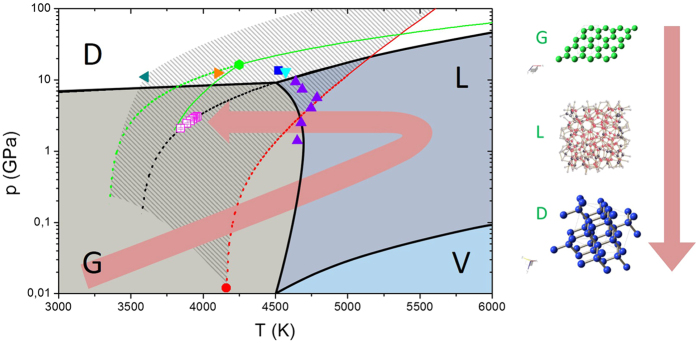
The phase diagram of carbon.The four regions of diamond D (white), graphite G (light grey), gaseous carbon V (light blue) and liquid carbon L (blue) are separated by coexistence lines (in black44). The coexistence line between diamond and liquid carbon (DL-line) falls in the grey-dashed region, which is bounded by the green DL-line (Ghiringhelli et al.42), and by the red DL-line (as described by Basharin39), and encloses the black DL-line (according to Zazula41). The dashed lines indicate the analytical continuations of the three curves. The dashed lines define a stable or metastable region for diamond nucleation. The red dot represents a metastable diamond at p = 0.012 GPa and T = 4160 K, obtained by quenching liquid carbon39. The purple triangles indicate the region of graphite melting measured by Togaya45. The dark green leftward triangle, orange rightward triangle, light green hexagon, blue square and light blue downward triangle represent the diamond-graphite-liquid triple points (DGL-points) according to Fateeva46, Bundy44, Ghiringhelli42, Glosli et Ree47, and van Thiel et Ree48, respectively. The purple squares describe our experimental system crossing the DL-line of Zazula from the right and becoming an undercooled liquid. Pressures of the purple squares were calculated from experimental laser intensities29. The red arrow indicates the evolution of the system in our experiment: from ambient temperature and pressure to liquid carbon, then to an undercooled liquid and finally to metastable diamond and graphite.